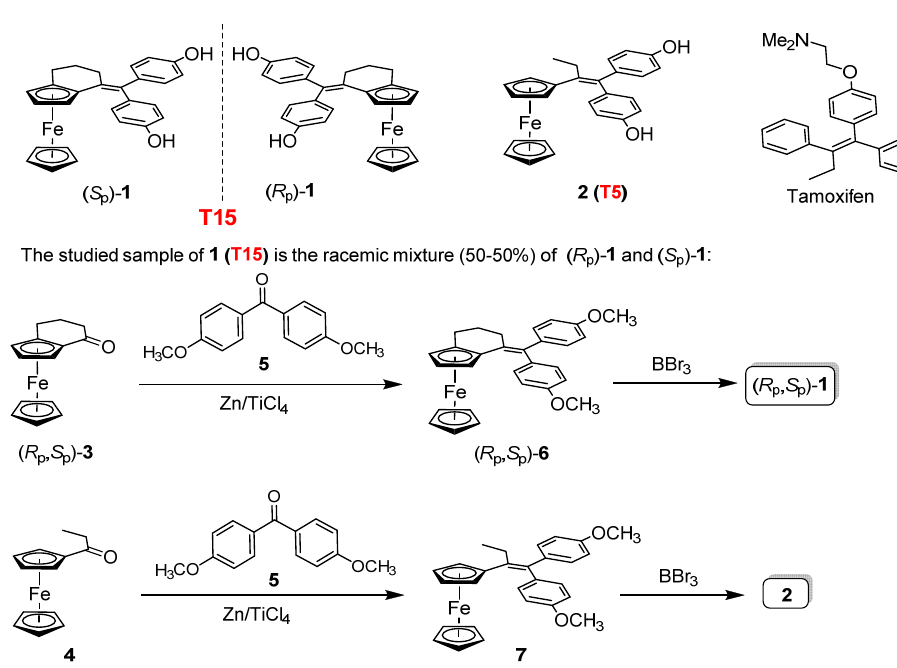
Figure 8. Chemical structure and the synthesis of the studied